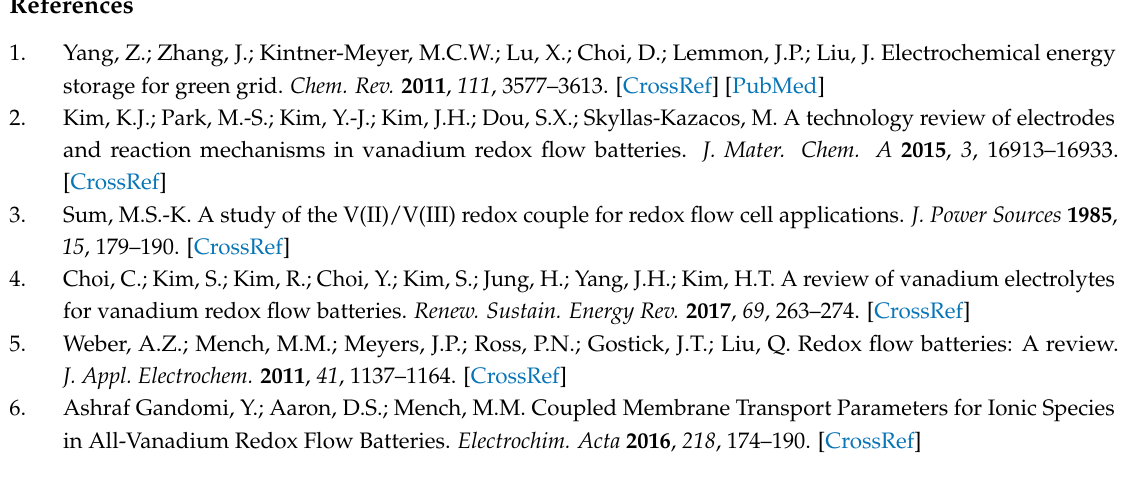
Figure S1: Possible loss of H 2 SO 4 during the sulfonation of PBI based blend membranes, Figure S2: FT-IR spectrum of F6-PBI membrane as a function of sulfuric acid doping time (30% sulfuric acid at room